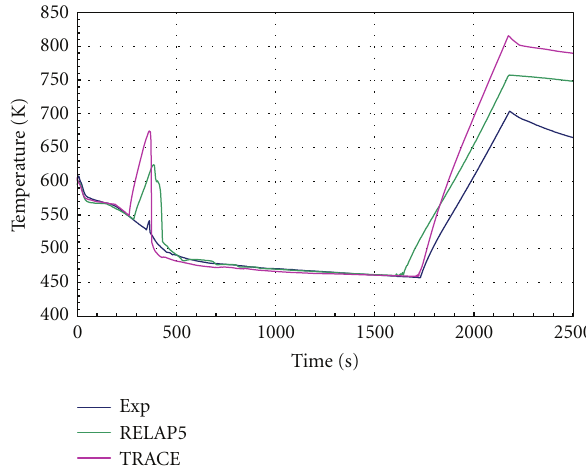
Figure 8: Pressurizer pressure.